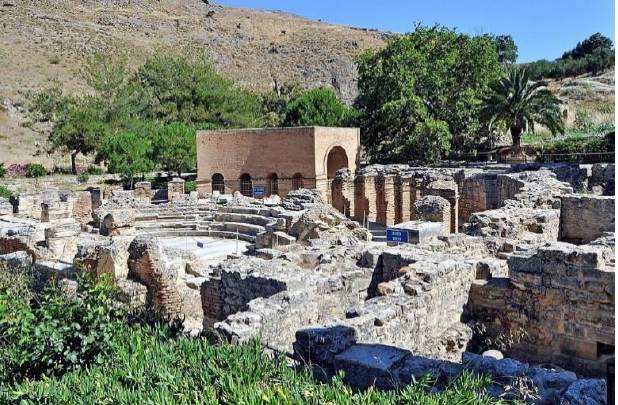
Figure 11. Roman Gortyn with a view of Trajan ’ s Odeon (photo: A. N. Angelakis).